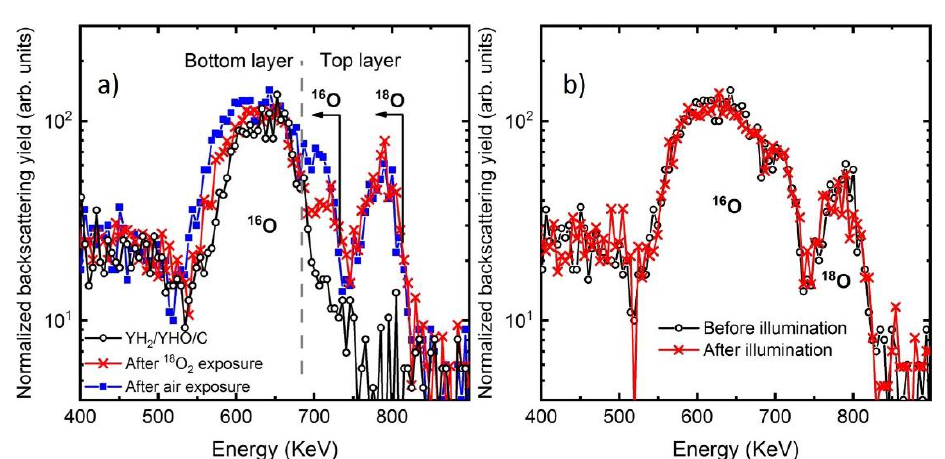
Fig. 2. Oxygen RBS signals of the bilayer film (a) recorded for the as deposited sample (black open circles), after exposure to 18 O 2 of pressure 3×10 -3 mbar for 3 min (red crosses) and oxidation in air (blue squares). Oxygen signals (b) before (black open circles) and after 10 min of illumination (red crosses).